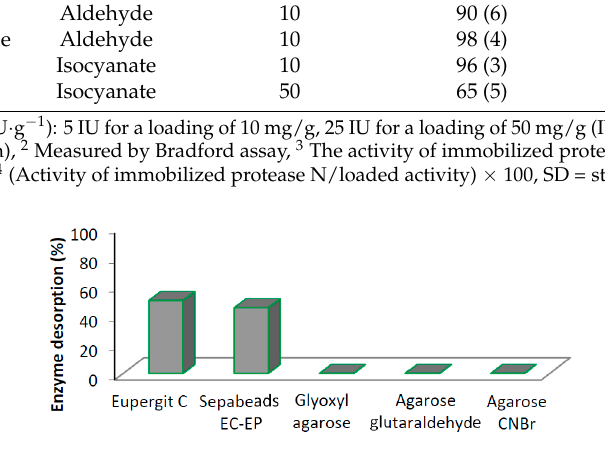
Figure 1. Desorption of protease N in the experimental conditions used for the hydrolysis of different peracetylated nucleosides.